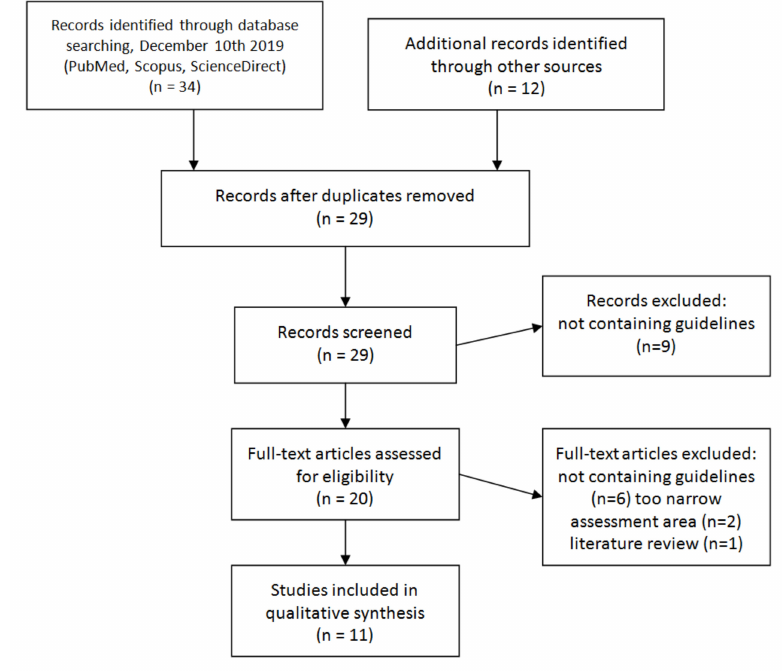
Figure 1. Flow chart of literature